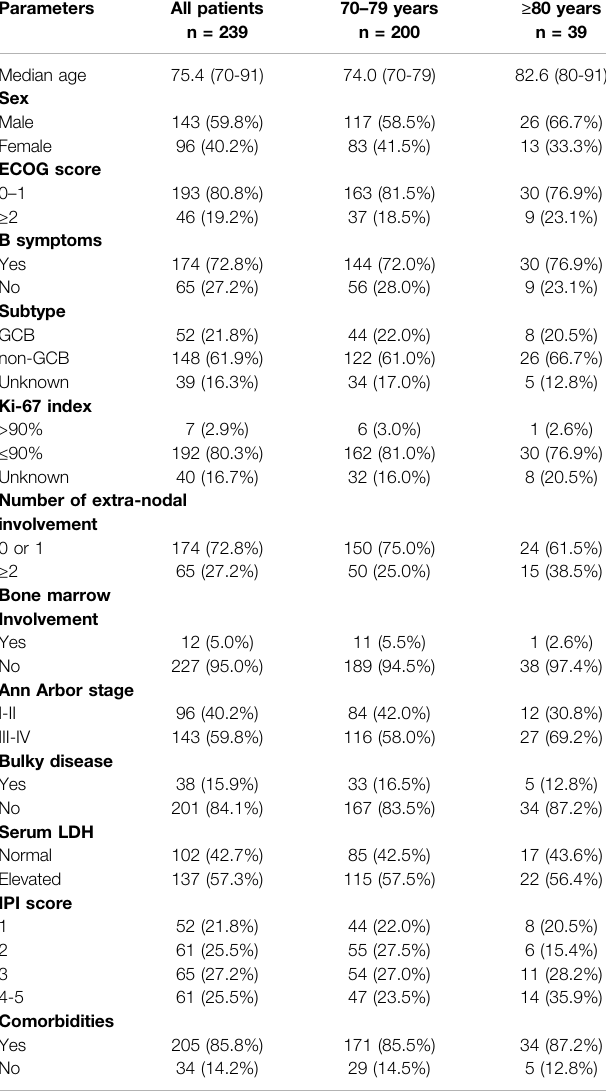
TABLE 1 | Clinical characteristics of 239 patients with DLBCL at